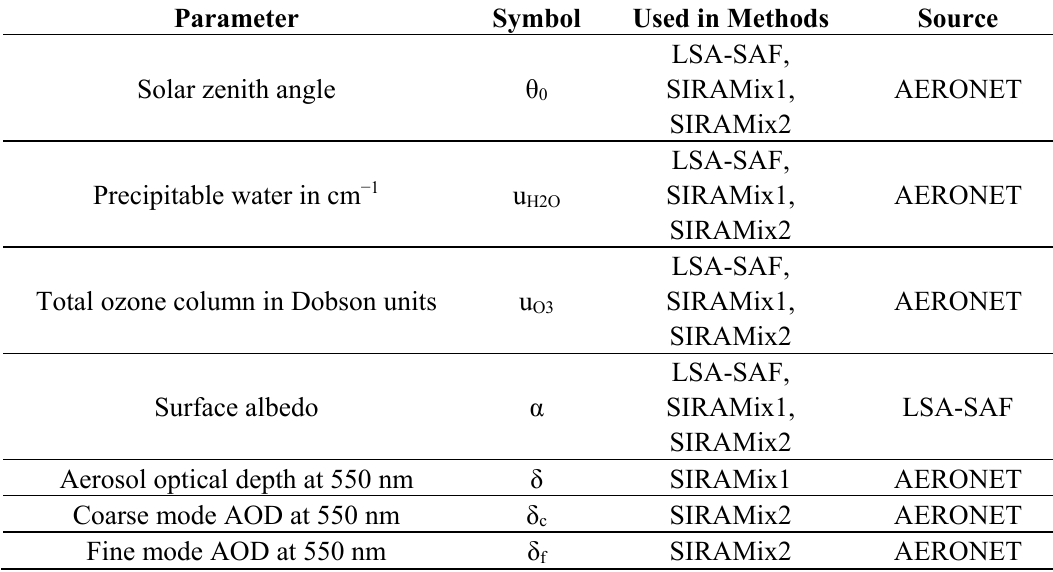
Table 4. Data used in the present study for the Land Surface Analysis Satellite